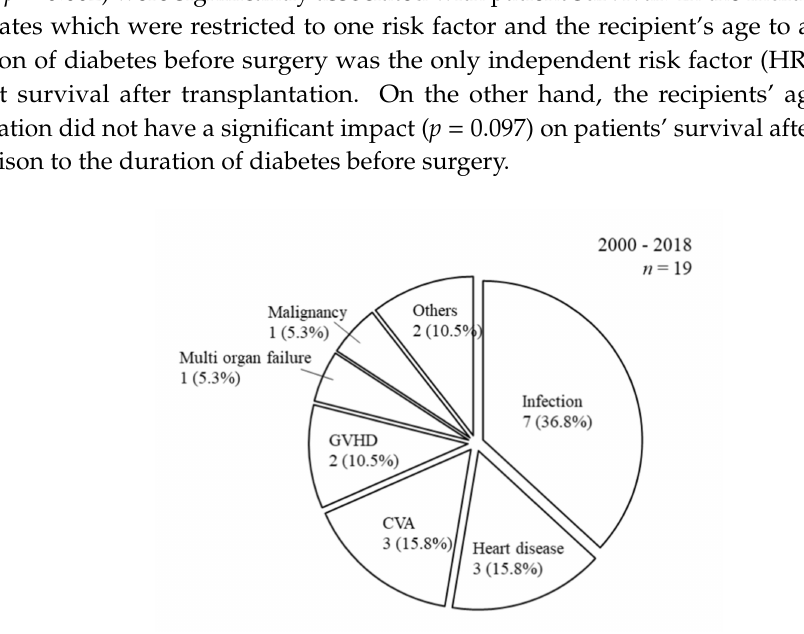
Figure 3. Causes of death after SPK. The causes of death after SPK were as follows: Infection ( n = 7; 36.8%), heart disease ( n = 3; 15.8%), cerebrovascular accident ( n = 3; 15.8%), graft versus host disease (GVHD; n = 2; 10.5%), multi-organ failure ( n = 1; 5.3%), malignancy ( n = 1; 5.3%), and others ( n = 2;